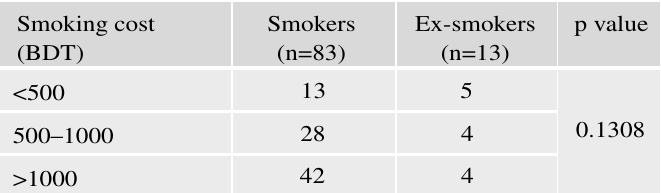
Table VI: Distribution of study subjects according to smoking cost